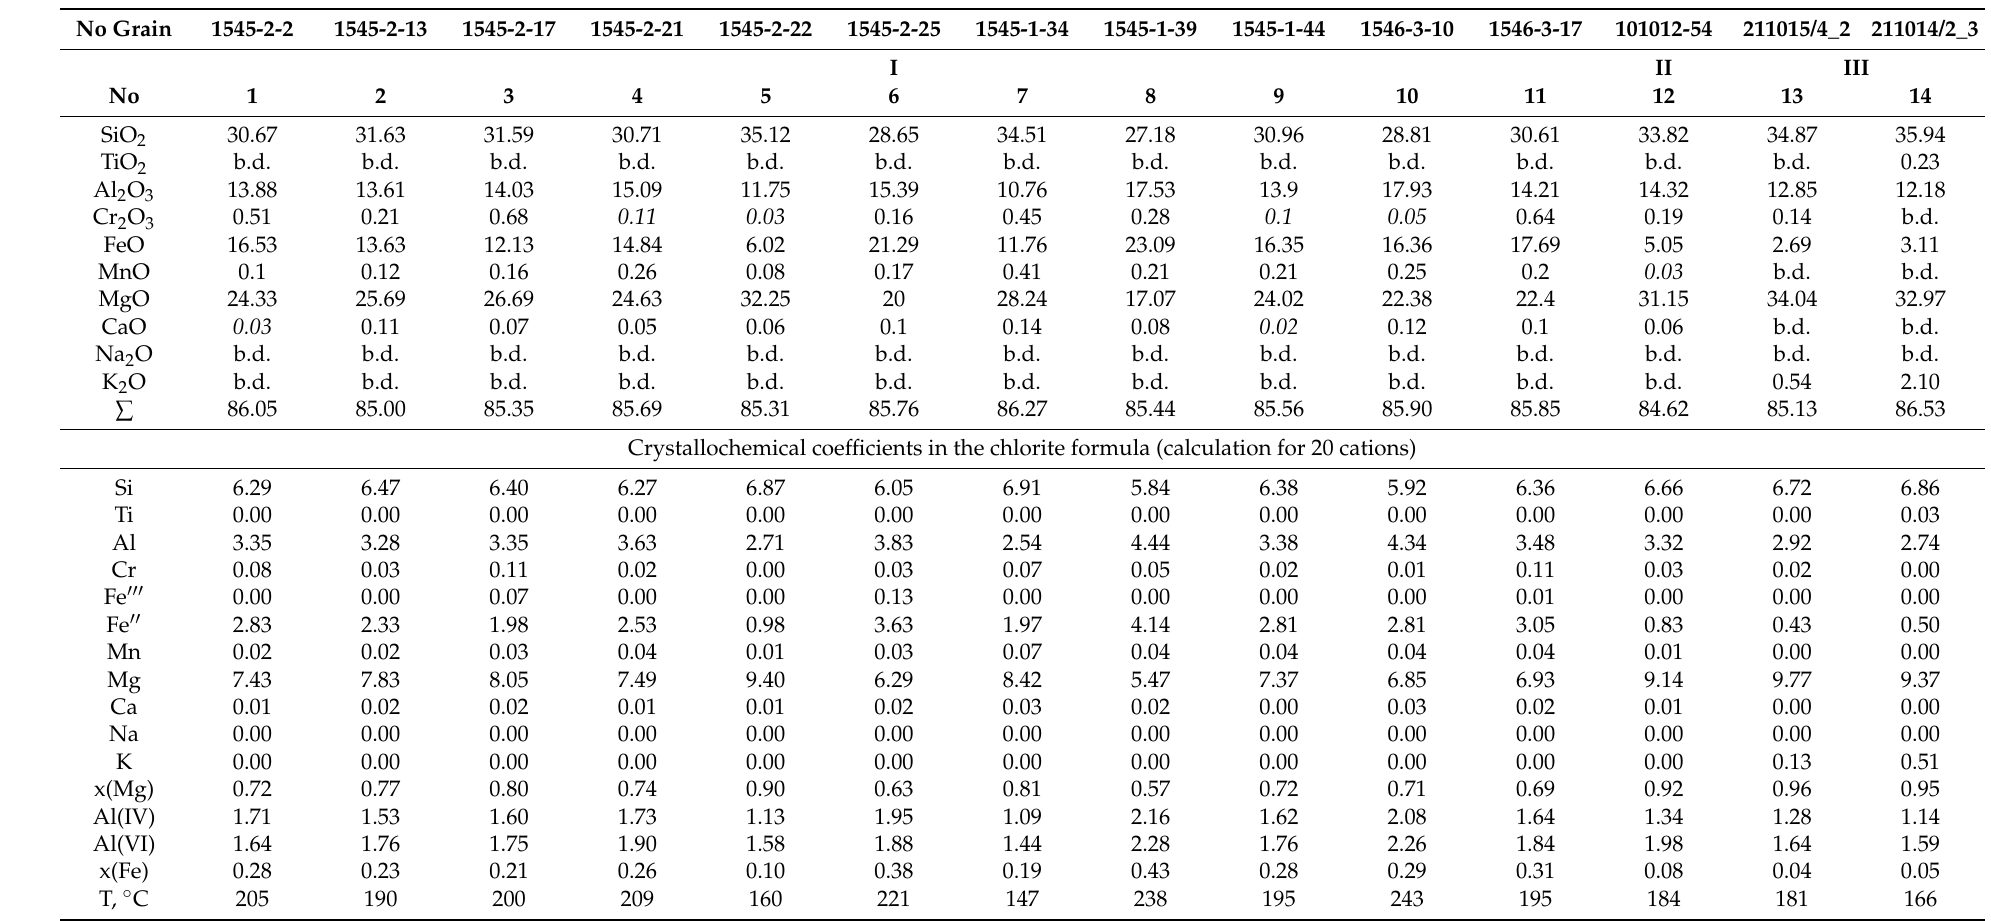
Table 6. Chemical composition of chlorite from clinopyroxenites I–III (in wt.%) and calculated temperatures of its